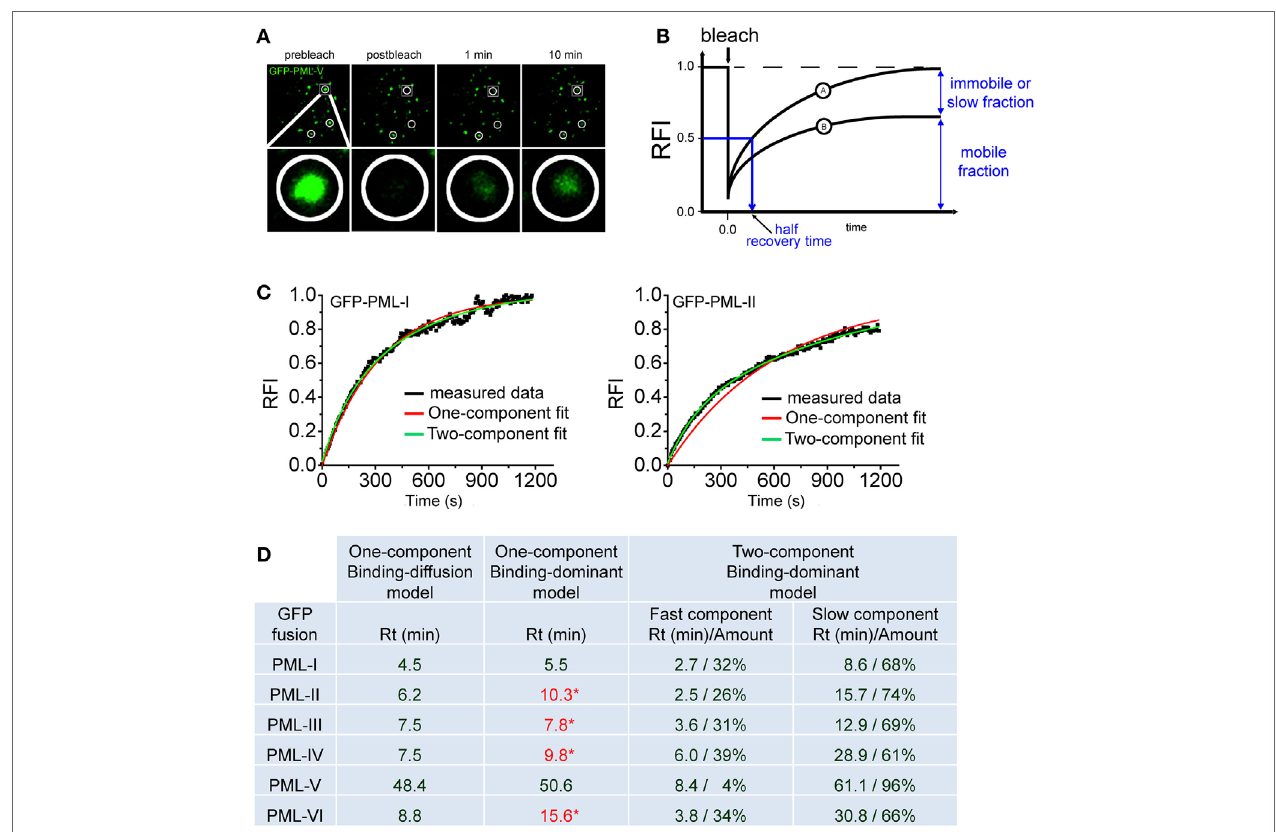
FigURe 4 | Fluorescence recovery after photobleaching (FRAP) to assess component exchange at promyelocytic leukemia (PML) nuclear bodies. (A) A typical FRAP experiment is shown. Two circular regions in the nucleus of a GFP-PML-V expressing U2OS cell were exposed to a short 488 nm laser bleach pulse and fluorescence redistribution was monitored over time. A third circled unbleached region at the bottom of this nucleus is shown as a positive control. One particular bleach spot is shown in a magnified view in the bottom panels. (B) Quantitation of FRAP experiments. After background subtraction, compensation for imaging-induced photobleaching and normalization, typical FRAP curves are obtained. FRAP curve A shows full recovery to prebleach fluorescence values indicating complete exchange of the GFP-tagged protein in the bleached spot within the observation time. In FRAP curve B, fluorescence recovery is not complete within observation time indicating an immobile fraction of molecules or a fraction with a very slow exchange rate. (C) FRAP curve fitting using exponential functions. FRAP curves for GFP-tagged PML-I (left) and PML-II (right) were fitted with one-component (red) or two-component (green) exponential functions. (D) Table showing the residence time (Rt) in minutes of GFP-tagged PML isoforms I to VI derived from fitting FRAP curves employing different mathematical models (See text for details). * numbers in red letters represent Rt values derived from one component modeling which failed to precisely fit to the measured FRAP curve as shown for GFP-PML-II in (C)